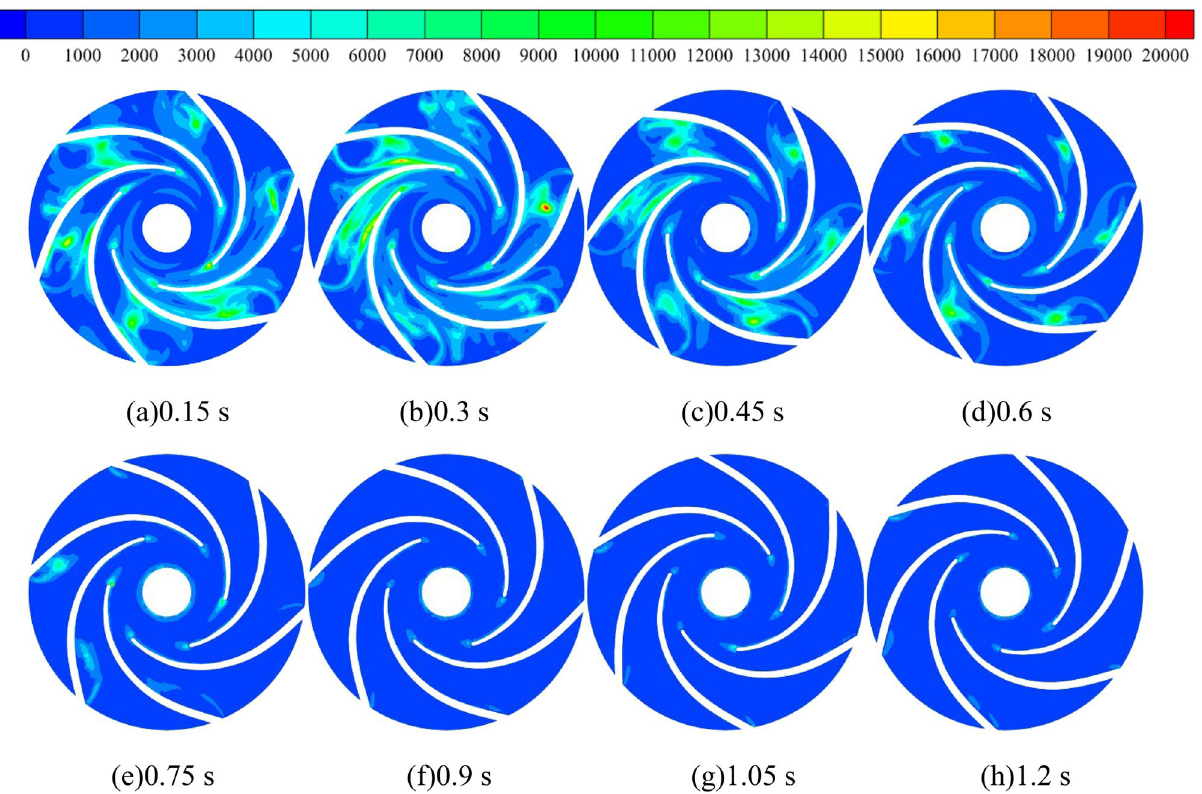
Figure 21. Entropy production distribution in the domain of the pump as turbine impeller during medium- speed start-up (W/(m 3